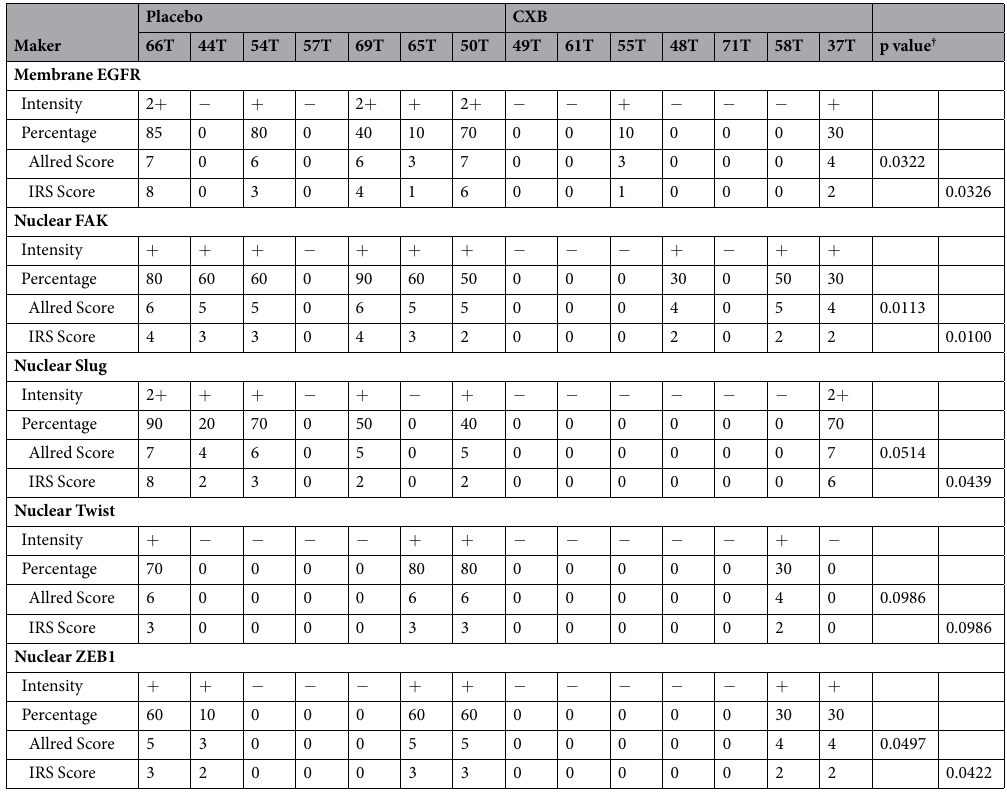
Table 1. Expression level of upstream EMT signalling in the tumour xenograft mice model by IHC combined semiquantitative scoring systems. † The p value was calculated by the Wilcoxon signed-rank